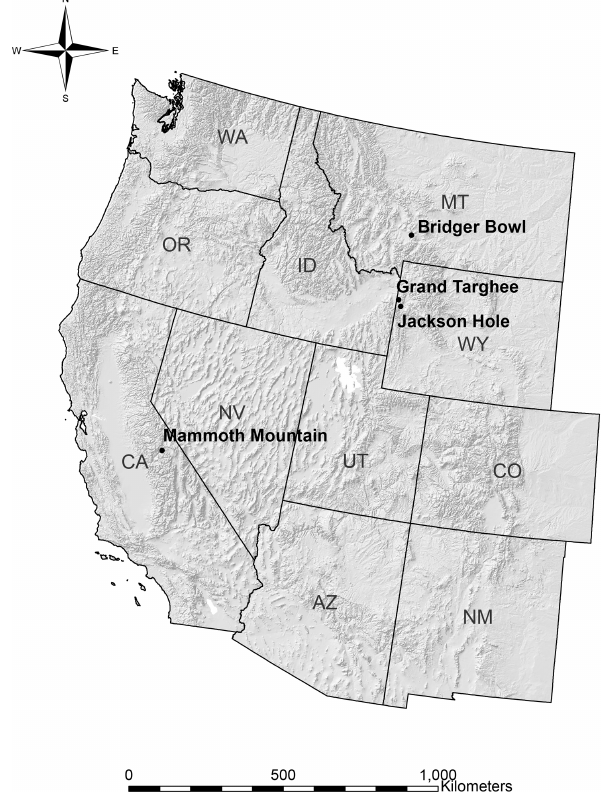
Figure 1. Location map of the sites used in this study. Geographic data from US Census Bureau (2017) and USGS National Center for EROS